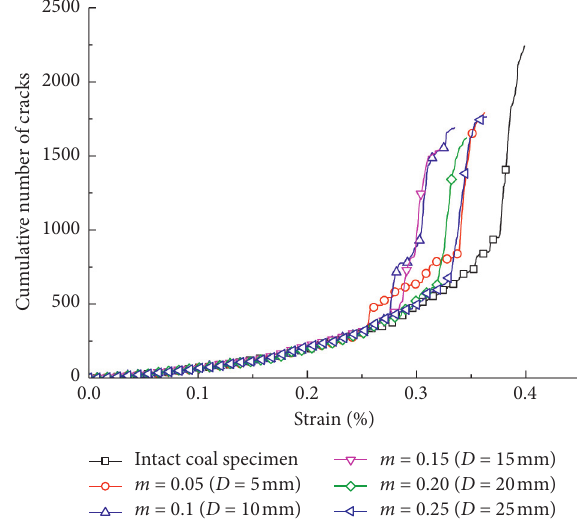
Figure 11: Curve of crack number and strain.